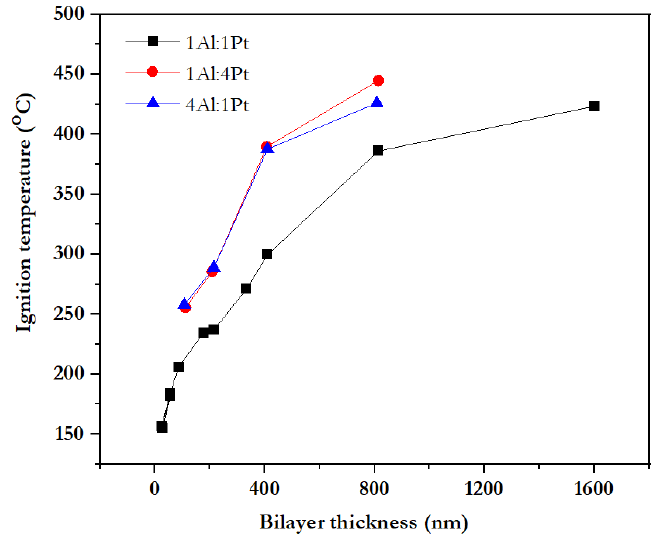
Figure 11. Variation of ignition temperature with function of bilayers with variation of composition [53] .